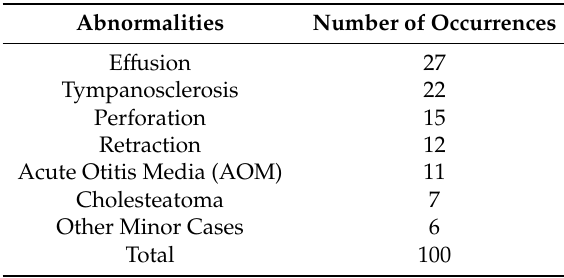
Table 1. Number of Abnormalities in Dataset 2.